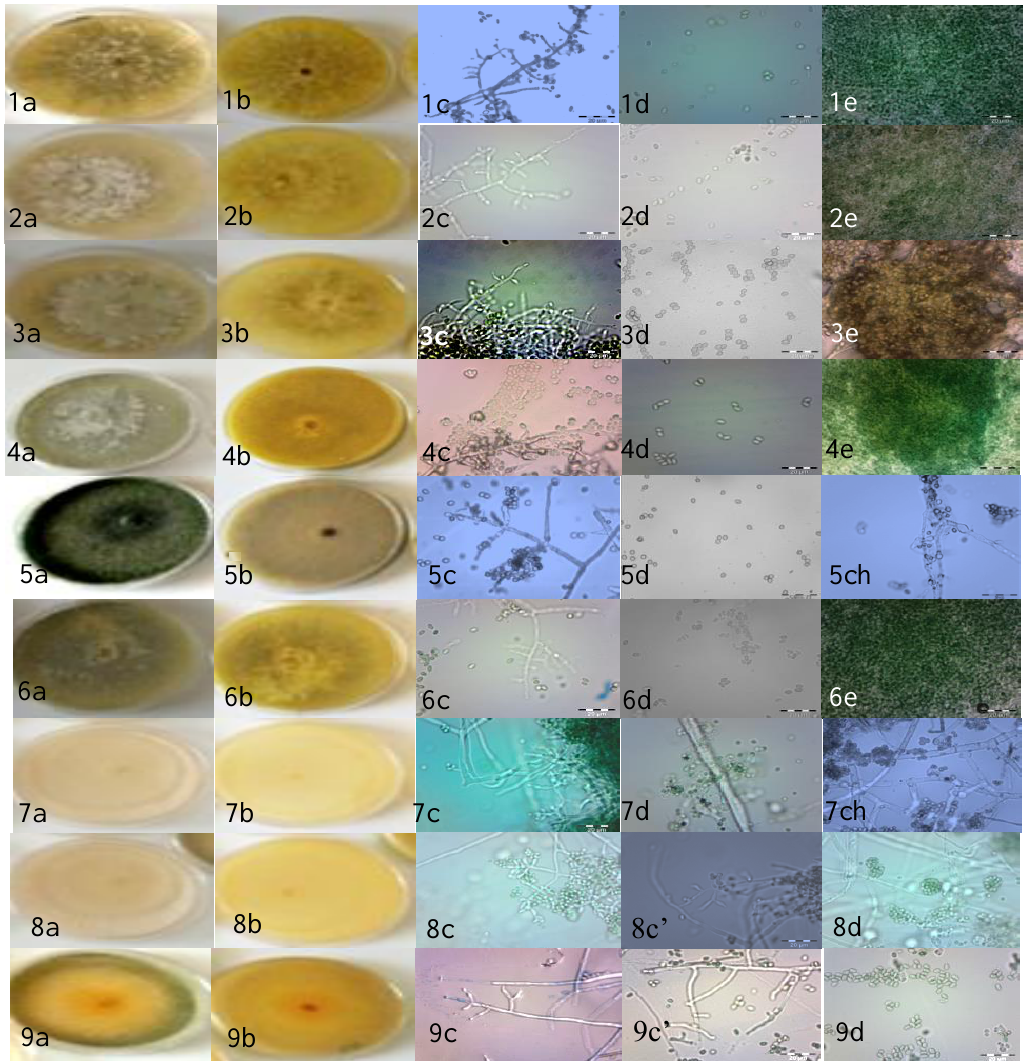
Figure 2. Trichoderma Potato Dextrose Agar (PDA) cultures . ( a ) Colony aspect after 5 days of growth at 28 °C, ( b ) reverse of colonies, ( c ) conidiophore, ( c’ ) phialides, ( d ) conidia, ( e ) pustule and ( ch ) chlamydospores of different Trichoderma strains. (1–4, 6) T. longibrachiatum ; (5, 9) T. afroharzianum ; (7, 8) T. atrobrunneum. Scale bars in the microscopic photographs: 20 μm.